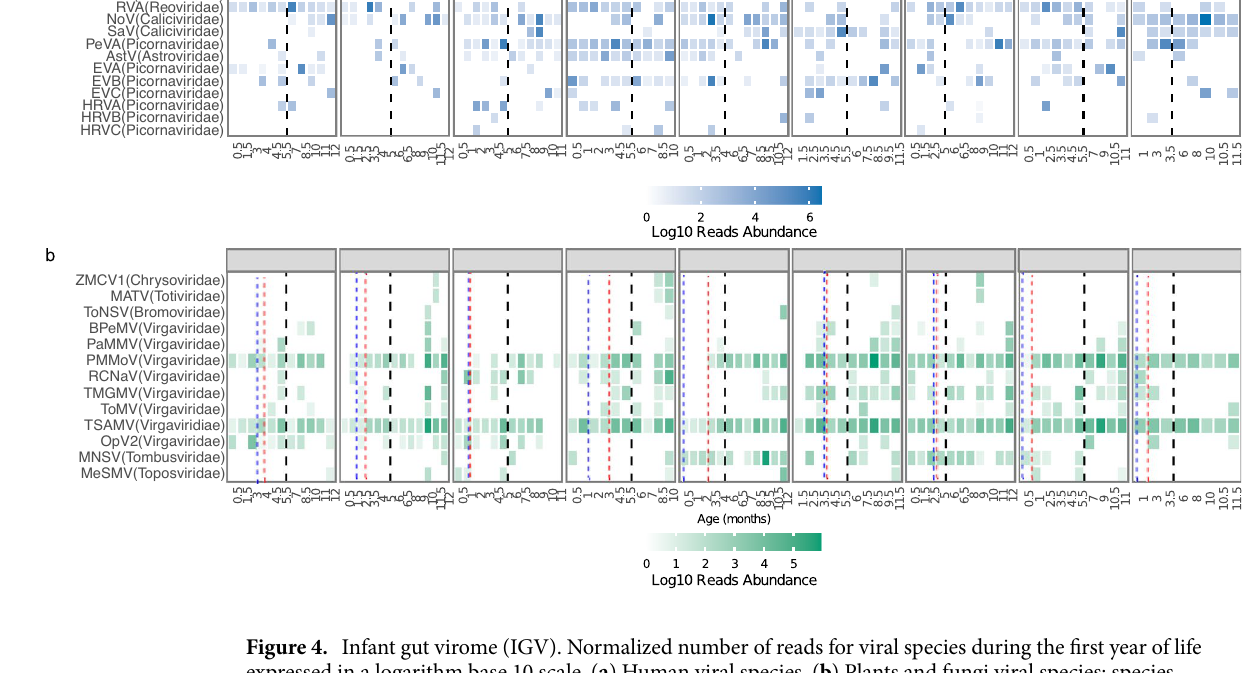
Figure 4. Infant gut virome (IGV). Normalized number of reads for viral species during the first year of life expressed in a logarithm base 10 scale. ( a ) Human viral species. ( b ) Plants and fungi viral species; species categorized as ‘sp.’ in Supplementary Table S6 were omitted from this figure. The family to which each species belong is shown in parenthesis. Each panel illustrates a child, with the identifier IGV at the top, and the age in months at the bottom. Black dotted lines divide the first and second halves of the first year of life, blue dashed lines indicate the introduction of liquids other than milk, and red dotted lines the introduction of fruits, and in some cases vegetables. Species that infect humans: TTV, torque teno virus; TTMV, torque teno mini virus; TTMDV, torque teno midi virus; HPV, human papilloma virus 1; HBoV, human bocavirus; RVA, rotavirus A; NoV, norovirus; SaV, sapovirus; PeVA, parechovirus A; AstV, mamastrovirus; EVA, enterovirus A; EVB, enterovirus B; EVC, enterovirus C; HRVA, rhinovirus A; HRVB, rhinovirus B; HRVC, rhinovirus C. Species that infect plants: ZMCV1, Zea mays chrysovirus; MATV, maize associated totivirus; ToNSV, tomato necrotic spot virus; BPeMV, bell pepper mottle virus; PaMMV, paprika mild mottle virus; PMMoV, pepper mild mottle virus; RCNaV, rattail cactus necrosis-associated virus; TMGMV, tobacco mild green mosaic virus; ToMV, tomato mosaic virus; TSAMV, tropical soda apple mosaic virus; OpV2, opuntia virus 2; MNSV, melon necrotic spot virus; MeSMV, melon severe mosaic